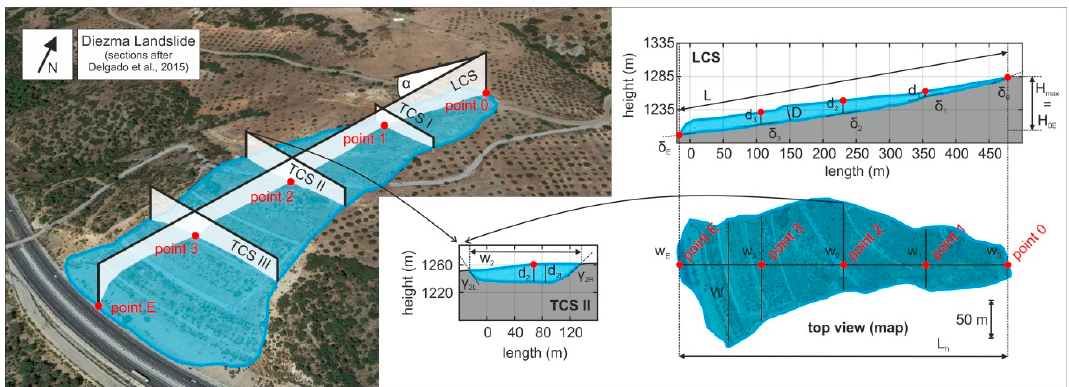
Figure 5. Schematic example of measurement of the parameters defining the rupture zone of the Diezma Landslide, Spain (No. 001.00 in Table A1 in the Appendix). Cross sections are drawn after Delgado et al. [35] (satellite imagery from Google Earth Pro [36]).